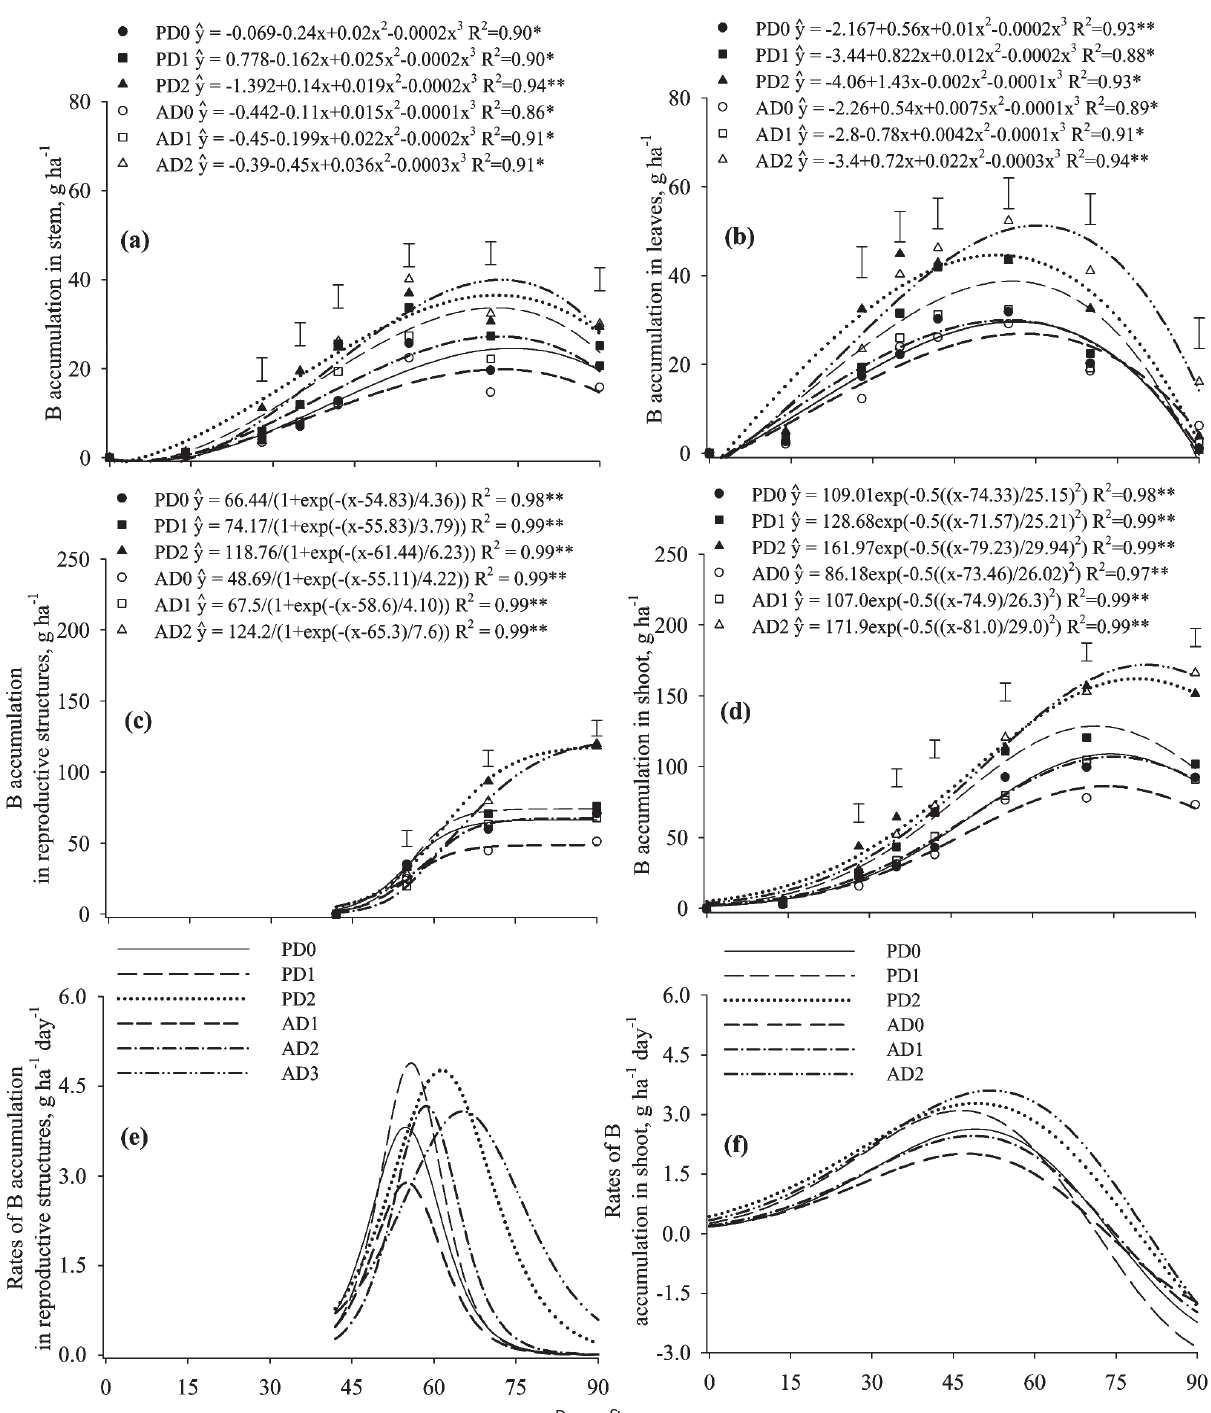
Figure 1. Boron accumulationin stem (a), leaves (b), reproductive structures (c), and shoot (d) and rates of accumulation of B in reproductive structures (e) and shoot (f) of common bean cultivars, under different levels of fertilization. ** and * are: significant at p 0.01 and p 0.05 by the F test. Vertical bars represent the Least Significant Difference (LSD) at p 0.05. PD0 = Pérola without NPK fertilization, PD1 = Pérola with 50 % of recommended NPK fertilization; PD2 = Pérola with 100 % of recommended NPK fertilization; AD0 = IAC Alvorada without NPK fertilization, AD1 = IAC Alvorada with 50 % of recommended NPK fertilization; AD2 = IAC Alvorada with 100 % of recommended NPK